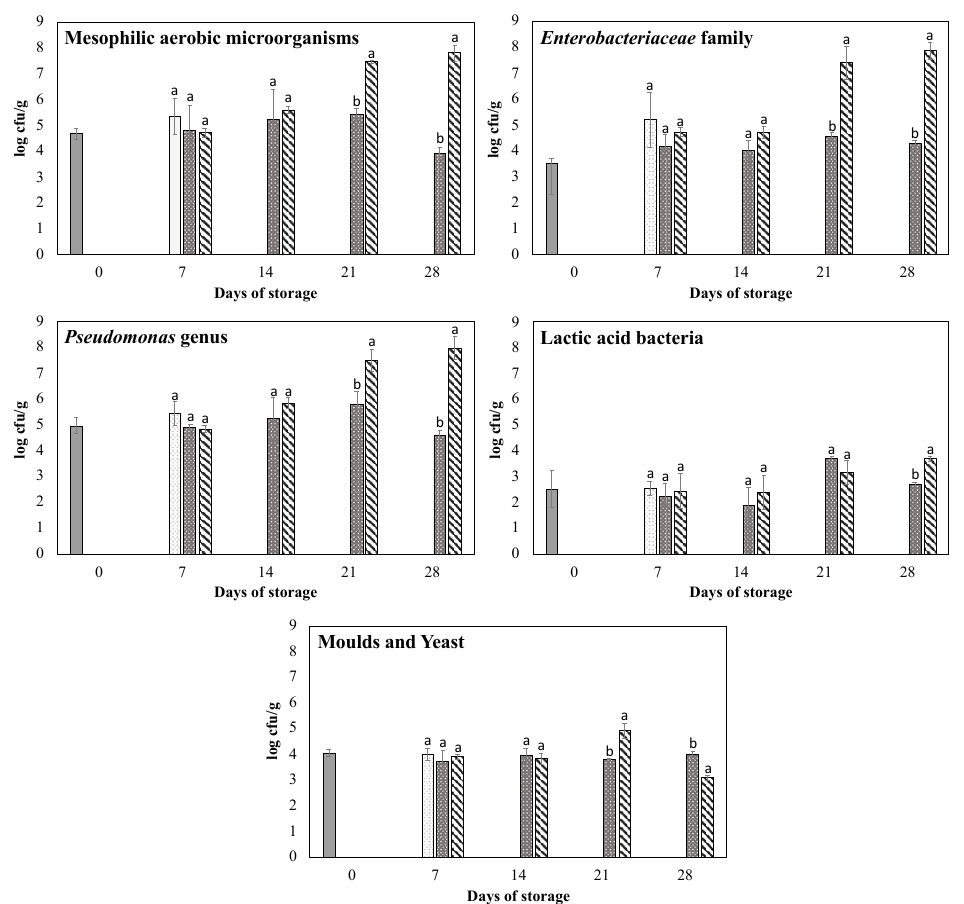
Figure 2. Time trend of mesophilic aerobic microorganisms, Pseudomonas genus, Enterobacteriaceae family, lactic acid bacteria and yeasts populations for fresh L. edodes stored under different conditions: initial counts, room temperature, refrigerated at 4 °C, and modified atmosphere packaging at 4 °C. Data expressed as mean ± standard deviation (SD) of three samples. a,b Different superscript letters within the same day of storage indicate statistically significant differences at p < 0.05.